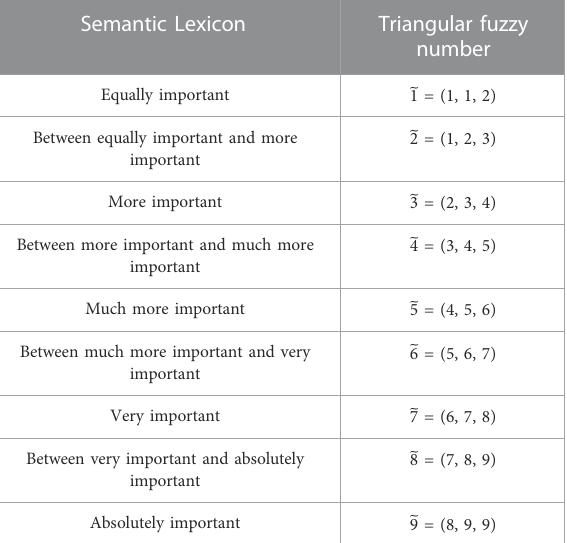
TABLE 1 Fuzzy evaluation scale. Semantic Lexicon Triangular fuzzy